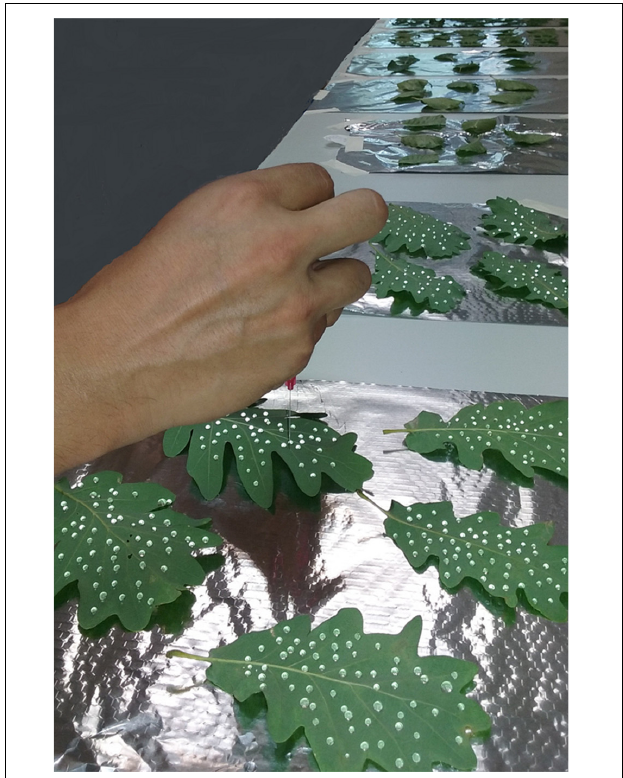
FIGURE 1 | Deposition of 150 mM CaCl 2 drops onto beech and sessile oak adaxial and abaxial plant surfaces using a micro-syringe to carry out a foliar absorption